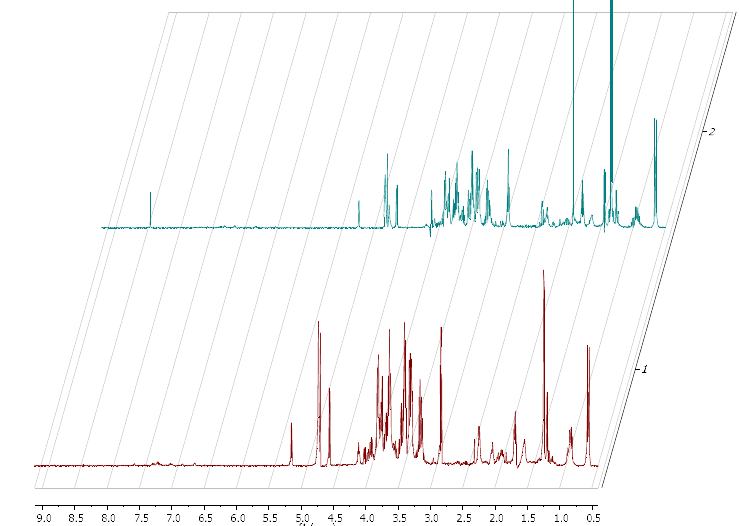
Figure 8. A part of the 1 H NMR spectrum of S. aureus adhered cells—2 h ( A ) transforming into biofilm within 12 h ( B ) .